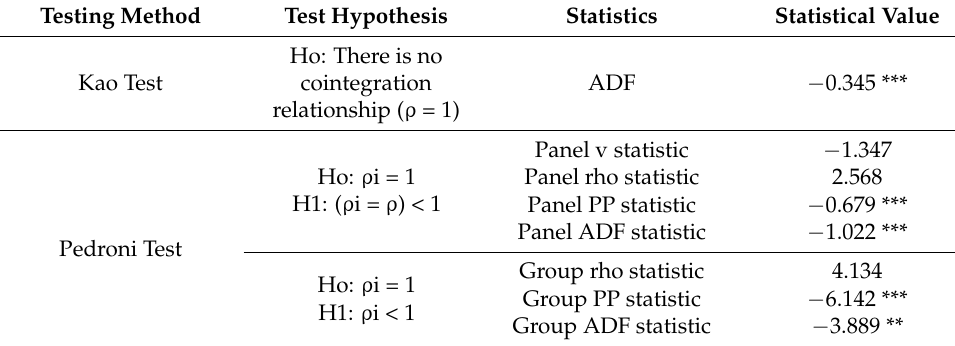
Table 4. Cointegration test results.